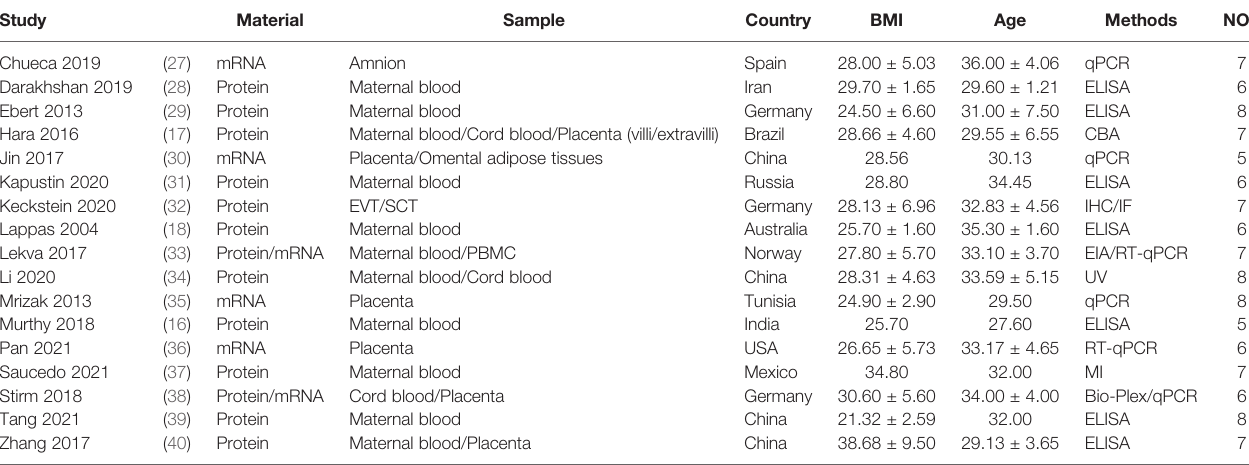
Protein Maternal